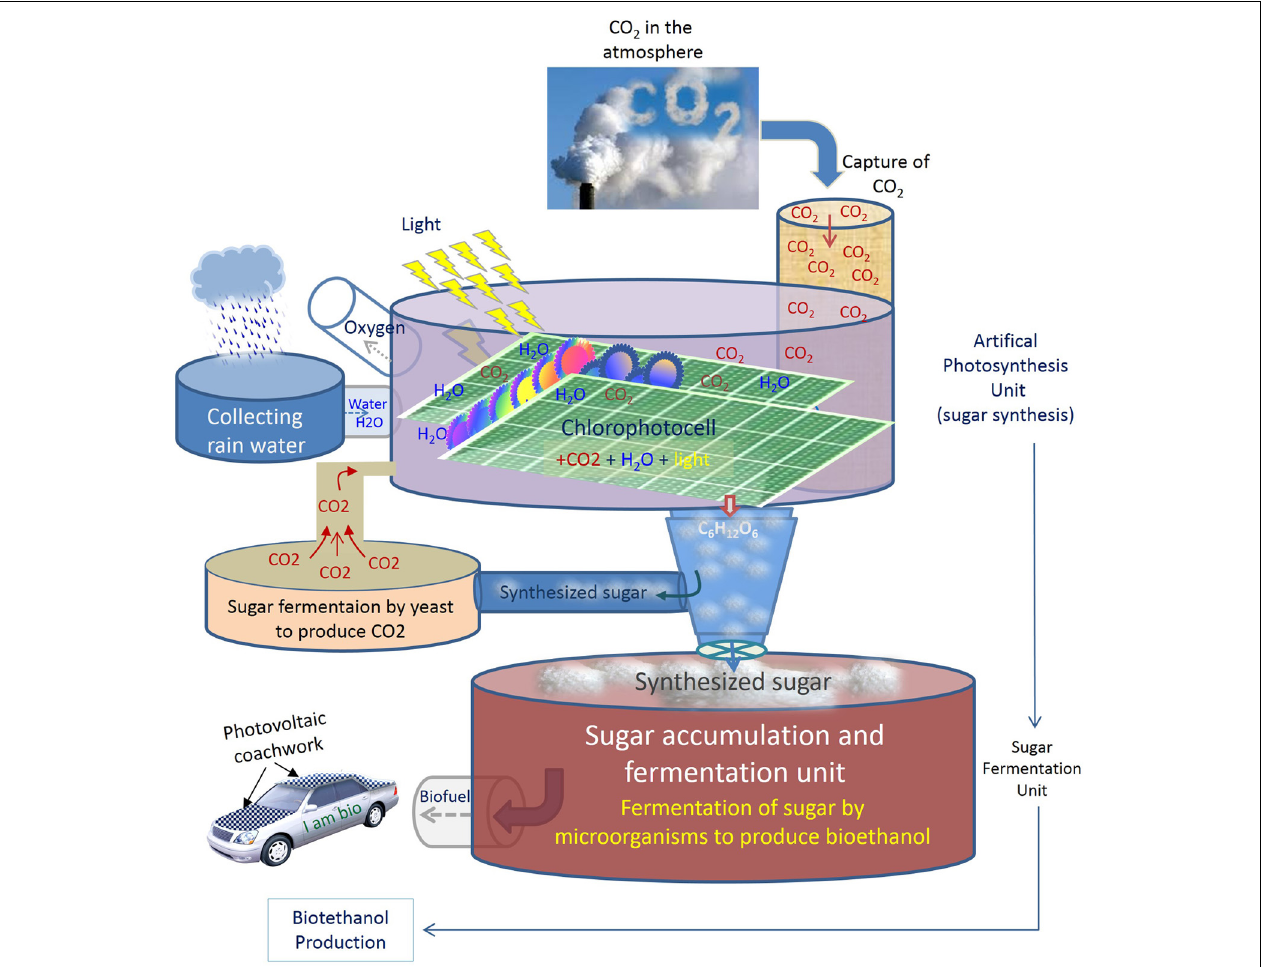
FIGURE 1 | General scheme of an artificial biosynthesis for the production of bioethanol from synthesized sugar. To save valuable crops (e.g., maize, beet) and water for more vital applications, an artificial photosynthesis can be used to produce fermentable sugar from CO 2 and water in a kind of artificial plastids (shown here as Chlorophotocell) as a photo bioreactor for sustainable energy production. An artificial photosynthesis system could be composed of a large unit with artificial plastids to capture solar light and atmospheric CO 2 and then convert them into sugar by chemical reaction. Produced sugar will be collected in another